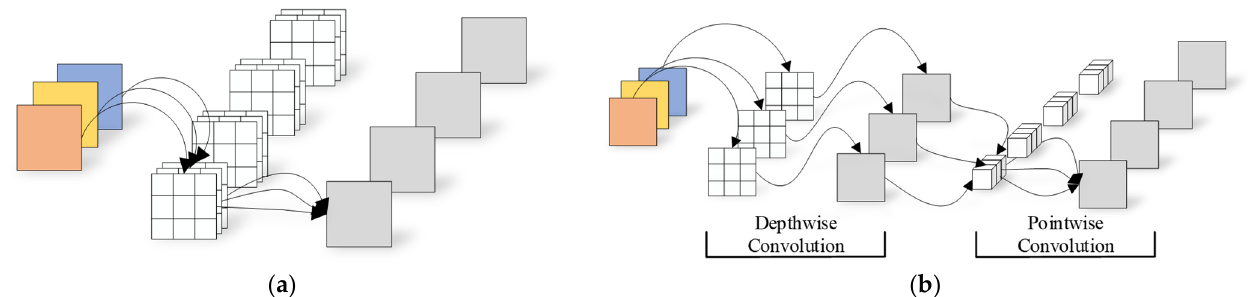
Figure 13. The type of convolution used in this article. ( a ) Ordinary convolution. ( b ) Depthwise separable